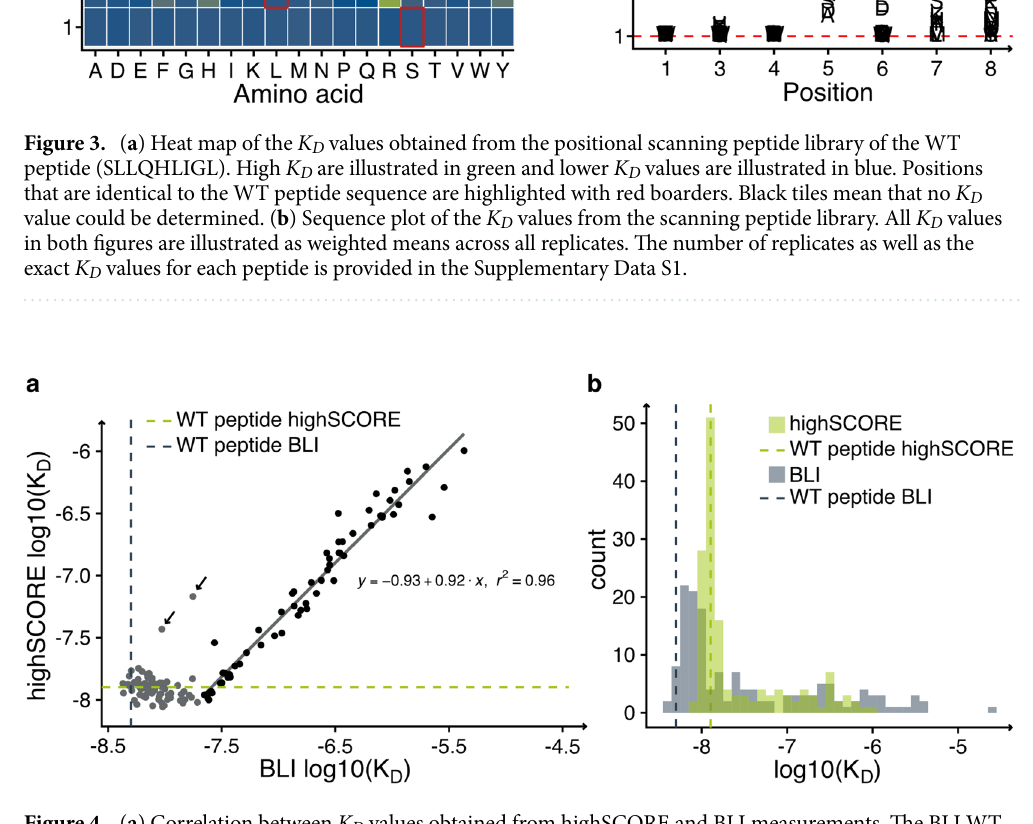
Figure 4. ( a ) Correlation between K D values obtained from highSCORE and BLI measurements. The BLI WT K D value is illustrated as blue dotted line and highSCORE WT K D as green dotted line. Arrows highlight points that stand out. Points colored in gray were excluded from the linear fit. ( b ) Histogram of the log 10 ( K D ) values for highSCORE (green) and BLI (blue) measurements. The BLI WT K D value is illustrated as blue dotted line and highSCORE WT K D as green dotted